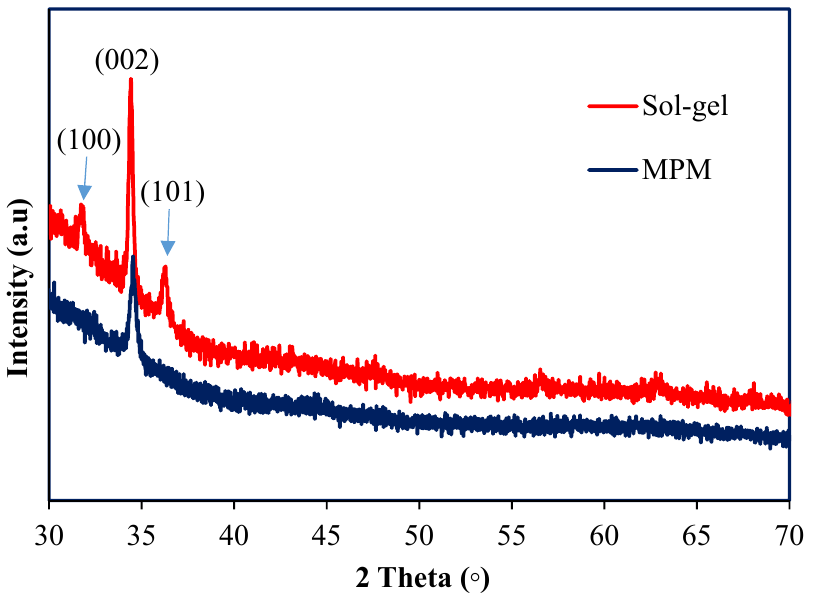
Figure 1. X-ray diffraction (XRD) patterns of ZnO fabricated via molecular precursor method (MPM) and sol–gel method.